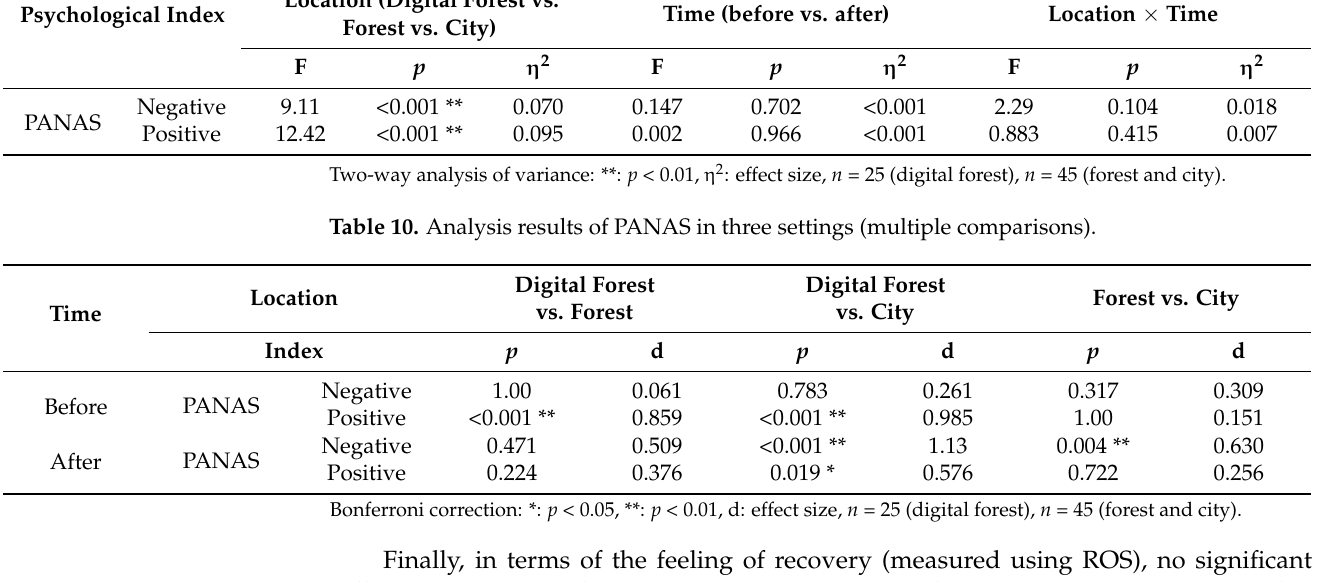
Table 9. Comparative analysis of PANAS in three settings (two-way analysis of variance). Main Effect Interaction Psychological Index